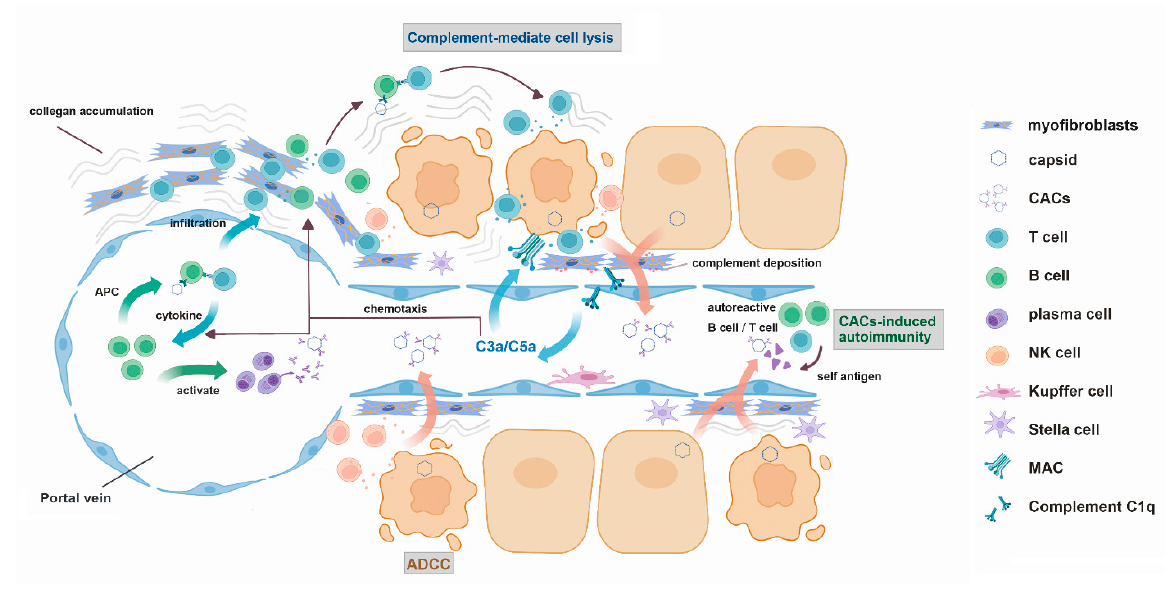
Figure 1. Proposed mechanism of CACs mediated liver injury. ADCC: antibody-dependent cellular cytotoxicity; MAC: membrane attack complex; APC: antigen presenting cell.